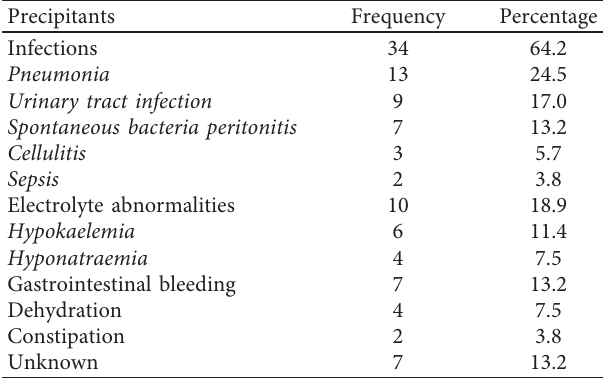
Table 1: Demographic characteristics, length of stay, and treatment outcomes against